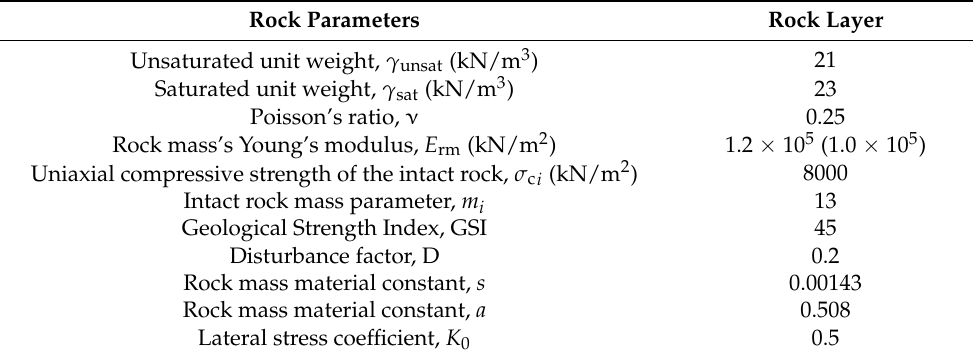
Table 2. Parameters for the Hoek–Brown model (with rock bolts and pipe roofings installed).